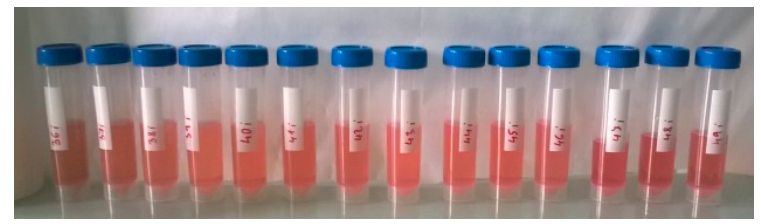
Figure 1. Snapshot of Rh aqueous solutions (2.4 × 10 − 3 M), ranging from (HCl) = 0.5 M on the left to (HCl) = 8 M on the right.